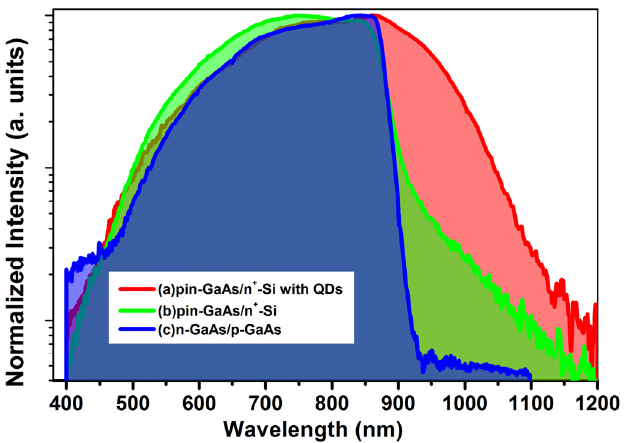
Figure 6. Spectral response of ( a ) pin-GaAs/ n + -Si with QDs (red); ( b ) pin-GaAs/n + -Si without QDs (green); ( c ) reference pin-GsAs on GaAs substrate